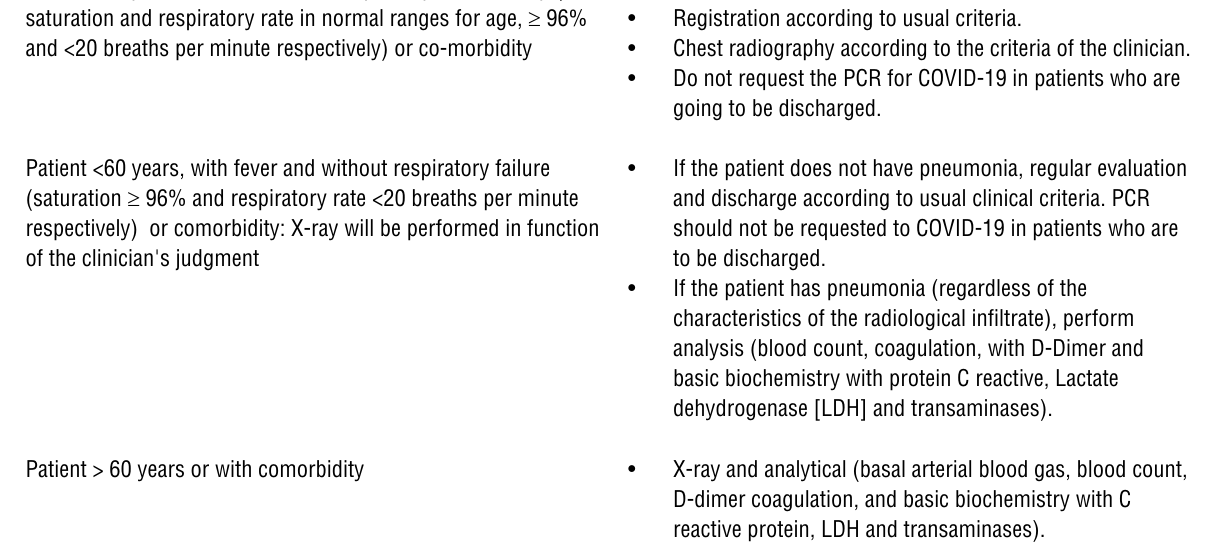
Table 3 - Ministry of Health, Consumption and Social Welfare (MSCBS). General measures for evaluation in the emergency department of the general population. April 2020 (8).